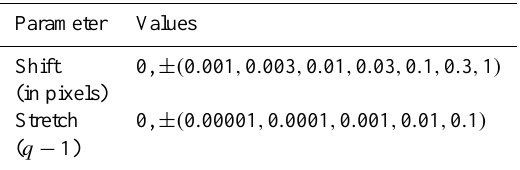
Table 1. Variations of shift and stretch applied to the synthetic spec-